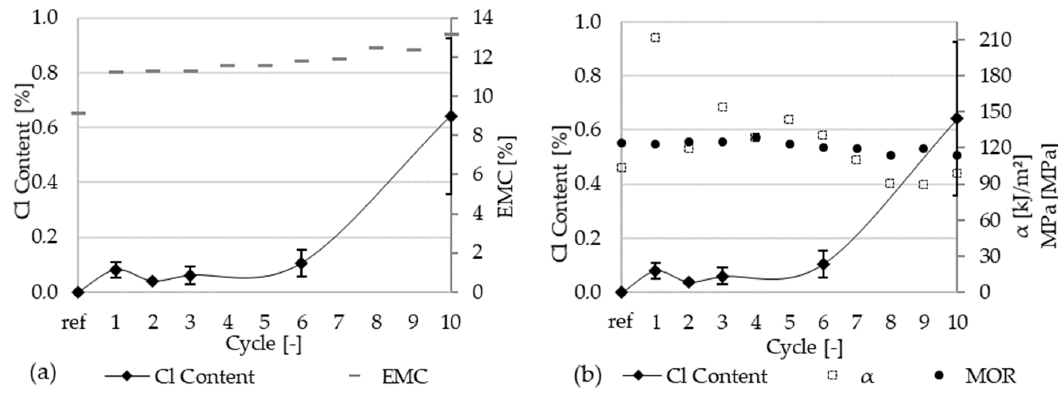
Figure 5. Cl content (%) (CC) of n = 6 samples where the standard deviation is given and the data points are connected by smoothed lines. ( a ) compares the equilibrium moisture content (%) with the CC and ( b ) shows MOR and α compared to CC of artificial weathering for birch solid wood for each cycle of n = 7 samples.